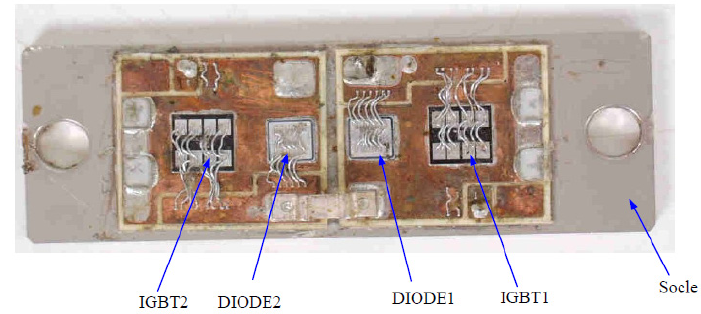
Figure 16. The interior of the studied IGBT module .